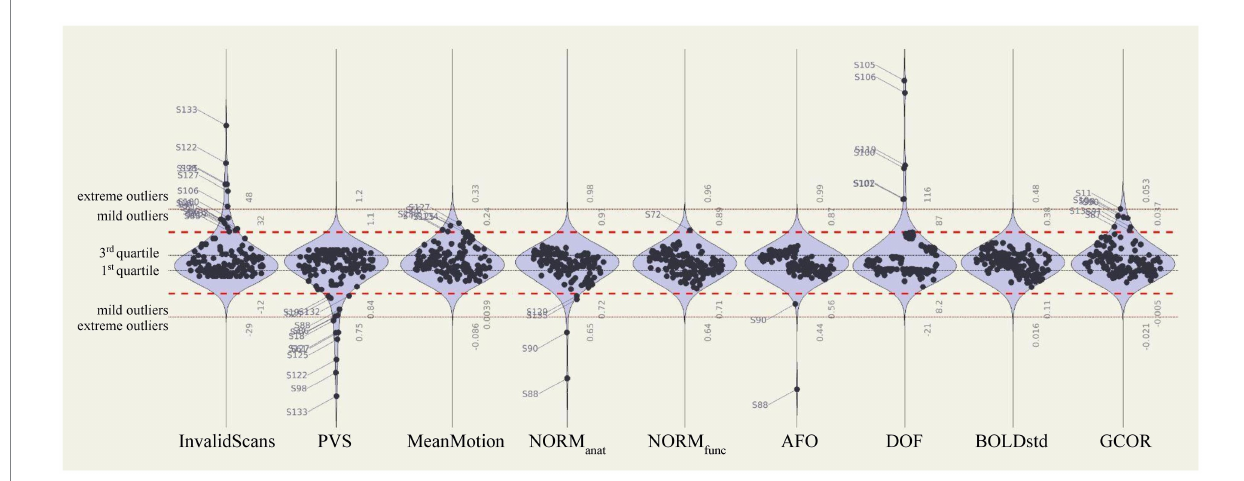
FIGURE 9 Automated quality control measures of preprocessed and denoised data. Distributions of automated QC measures extracted from the full fmri-open- qc-rest collection ( n = 139 anatomical and n = 151 functional data). QC measures were calculated from preprocessed functional (InvalidScans, PVS, MeanMotion, NORM func , and AFO), preprocessed anatomical (NORM anat and AFO), and denoised functional (DOF, BOLDstd, and GCOR) data. Extreme outliers were identified as values 3 IQR below the 1st quartile or above the 3rd quartile (red dotted lines). Mild outliers were defined as values 1.5 IQR below the 1st quartile or above the 3rd quartile (red dashed lines). BOLDstd, standard deviation of the BOLD signal; DOF, degrees of freedom; GCOR, global correlation; IQR, interquartile range; NORM func , MNI-space template to functional overlap; NORM anat , MNI-space template to anatomical overlap; PVS, proportion of valid scans.